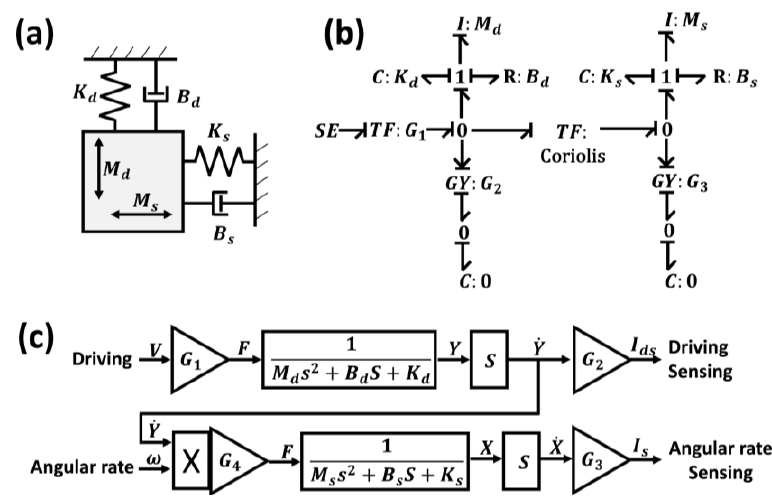
Figure 2. ( a ) Lumped mass–spring–damper model of a gyroscope. ( b ) Bond graph. ( c ) Equivalent system model.